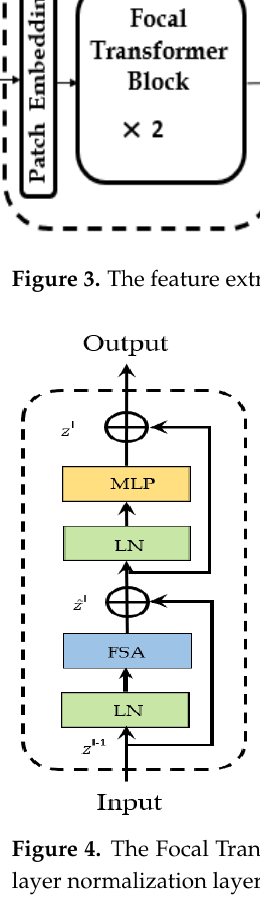
Figure 4. The Focal Transformer block. FSA is the focal − based self − attention module. LN is the layer normalization layer. MLP is the multi-layer perception network.